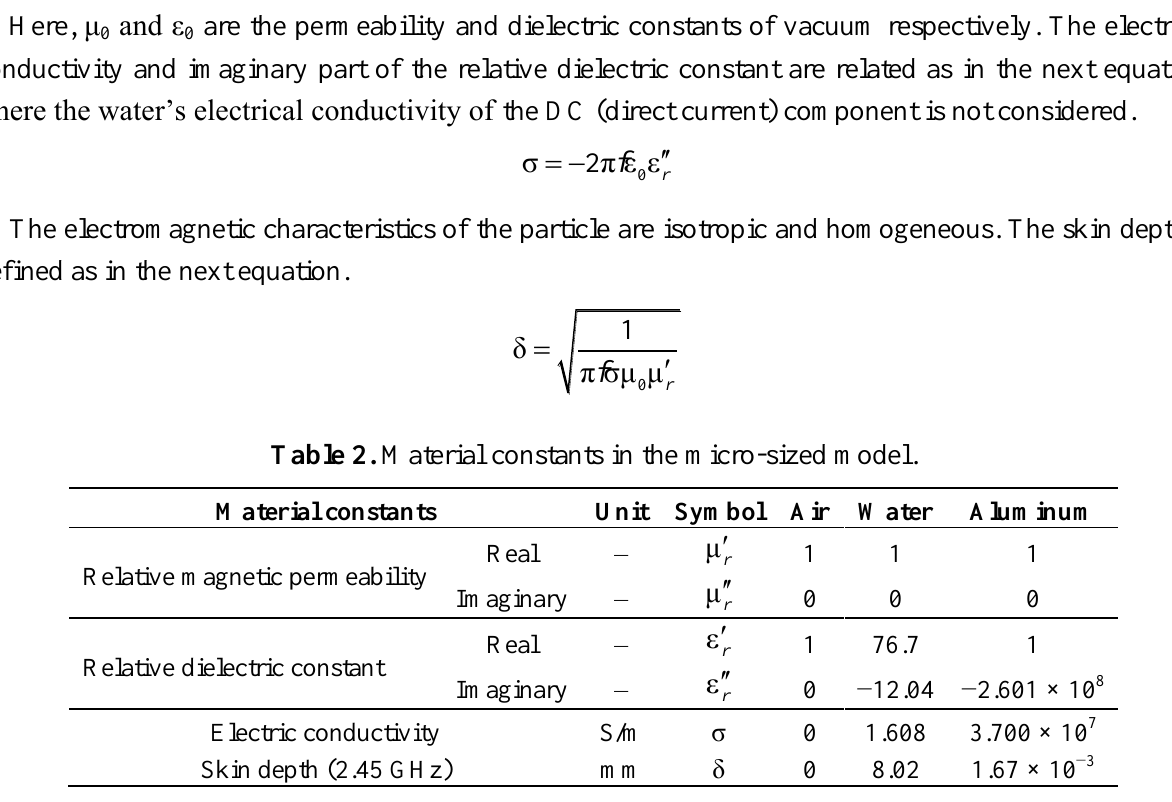
Figure 3. The fundamental structure used here continues repeatedly in three-dimensional